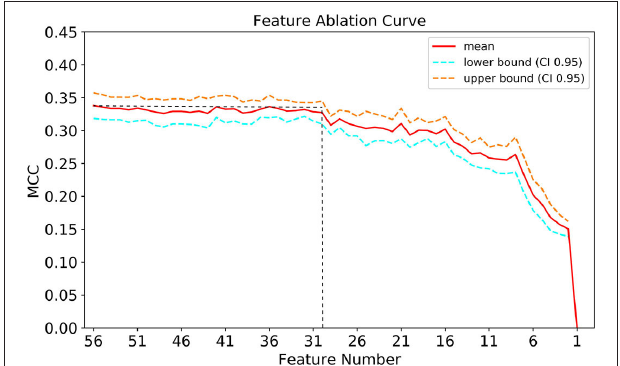
FIGURE 7 | Feature ablation curves of XGBoost model. MCC, Matthews correlation coefficient; CI, confidence